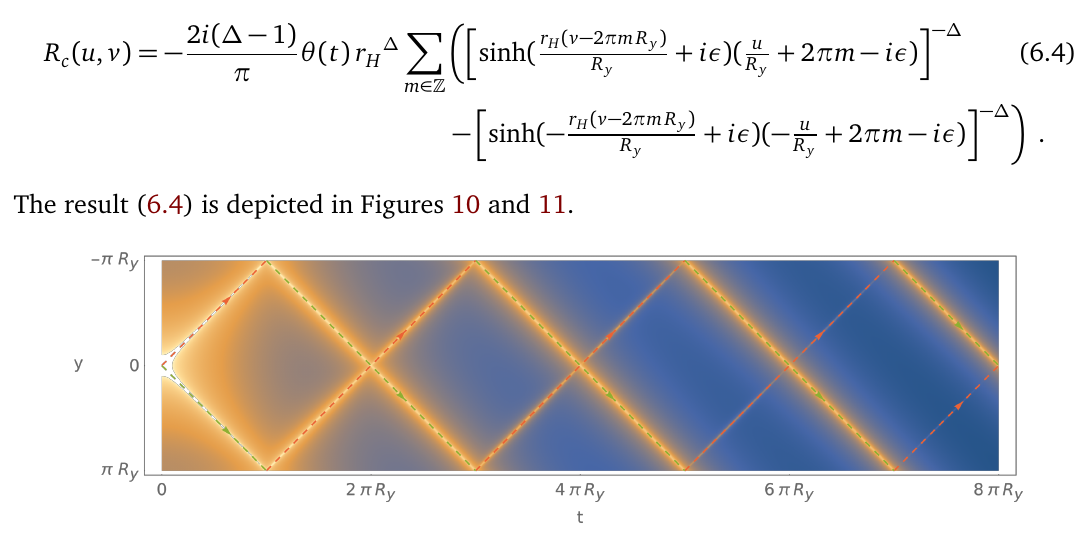
Figure 10: Logarithmic densityplot of the two-point function (6.4) on a cylinder ( t , y ) ∼ = ( t , y + 2 π R ) with r / R = π/ 20 (i.e. β = 20 and β → ∞ ). The two- y H y L R point function is sharply peaked on the light-cone (yellow), falling off polynomially in u (green arrows) and exponentially in v (red arrows). When following a light- ray (e.g. at constant v ), the two-point function has peaks with periodicity 2 π R y whenever it meets the light-ray going in the other direction. Note that there are no reflecting boundary conditions in this figure. Instead the y -circle is